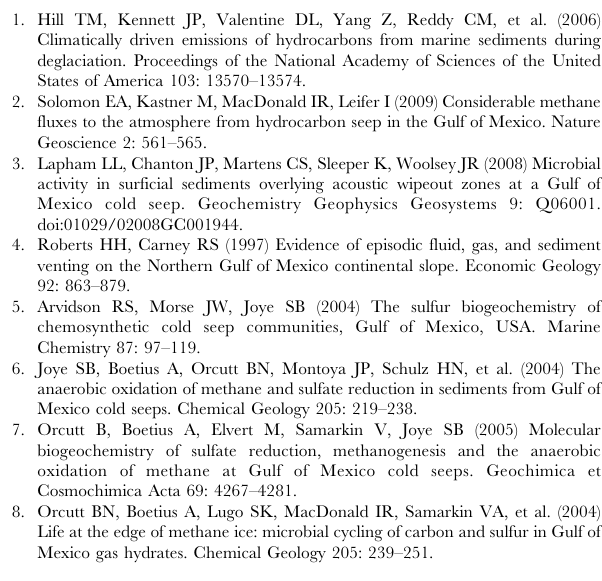
Figure S4 Comparison of Blast hits for sequence tags from V6 tag pyrosequencing and 16S rRNA sequences from RT-PCR clone libraries for 2 samples (12–15 cmbsf in Mat-B, and 12–15 cmbsf Out). Shown are 100% bar charts for A) bacteria and B) archaea. Figure S5 Neighbor-joining tree of amino acid translations of dsrAB transcripts for all samples. The nodes are labeled with parsimony-based boostrap values (1000 repetitions) that were over 60%. Sequences from dive 3570 are in colors corresponding to those of Fig. 3b groupings. Figure S6 Neighbor-joining tree of cDNA of full-length archaeal 16S rRNA sequences for all samples. The nodes are labeled with parsimony-based boostrap values (1000 repetitions) that were over 60%. OTUs are based on 98% similarity. Sequences from dive 3570 are in colors corresponding to those of Fig. 4a groupings. Figure S7 Neighbor-joining tree of amino acid translations of mcrA transcripts for all samples. The nodes are labeled with parsimony-based boostrap values (1000 repetitions) that were over 60%. Sequences from dive 3570 are in colors corresponding to those of Fig. 4b